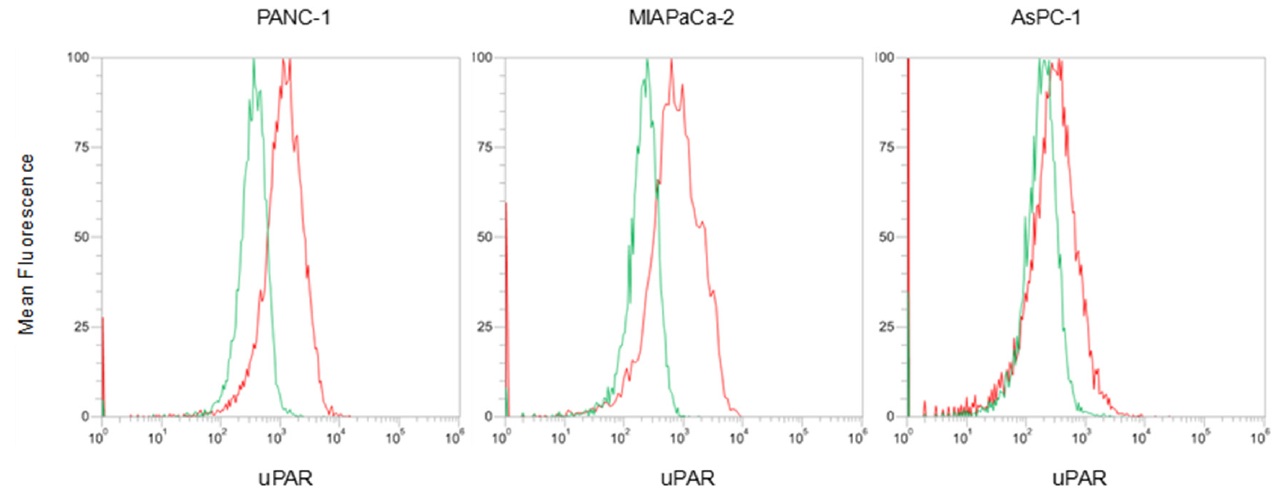
Figure 6. FCM histograms showing the evaluation of uPAR expression on membrane of PDAC cells. Green—cellular autofluorescence; red—uPAR-positive cells.